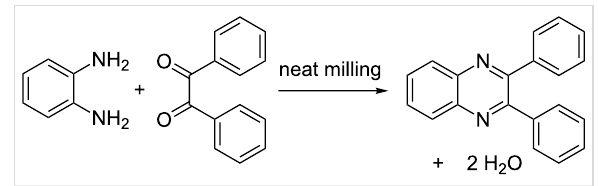
Scheme 1: Milling synthesis of 2,3-diphenylquinoxaline from benzil and ortho -phenylenediamine